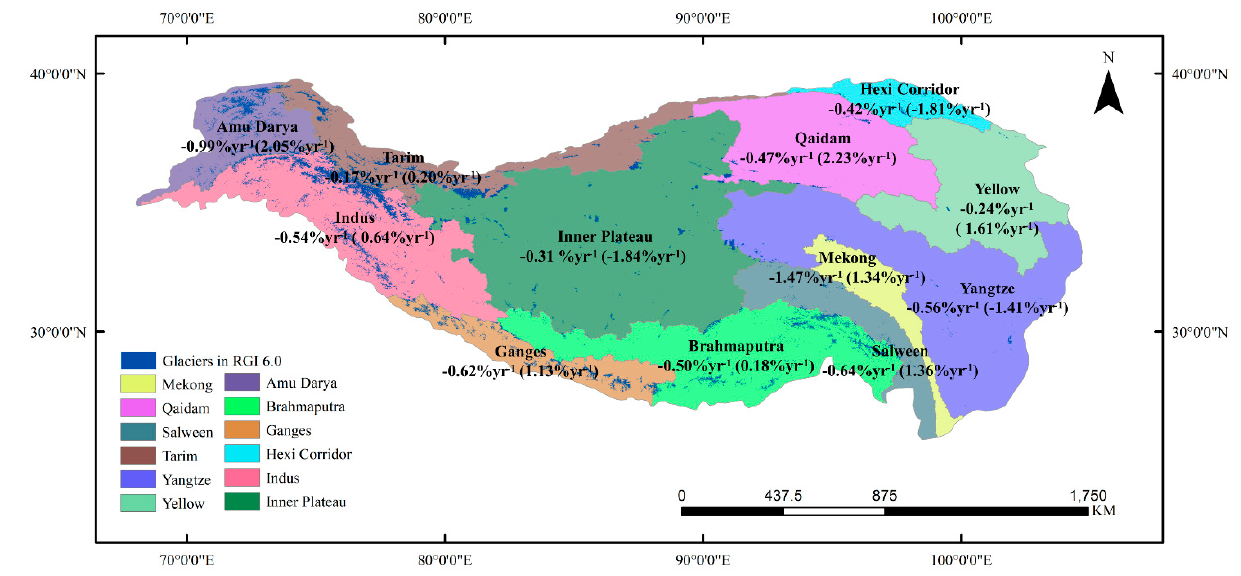
Figure 7. Rate of glacier change in the basins of the Tibetan Plateau. Numbers outside and in parentheses are the rates of change for clean and debris-covered glaciers, respectively.